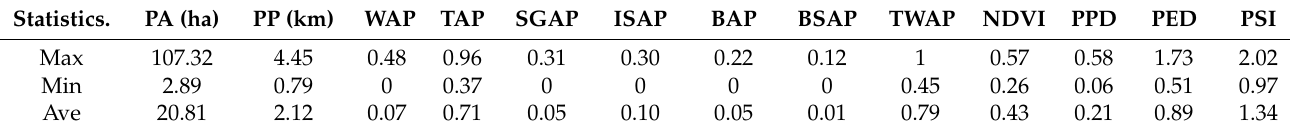
Table 3. The statistics of urban park